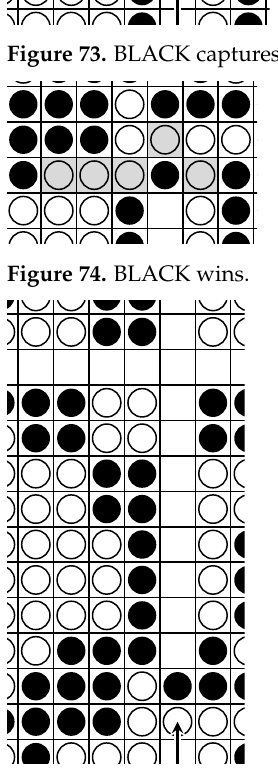
Figure 75. WHITE